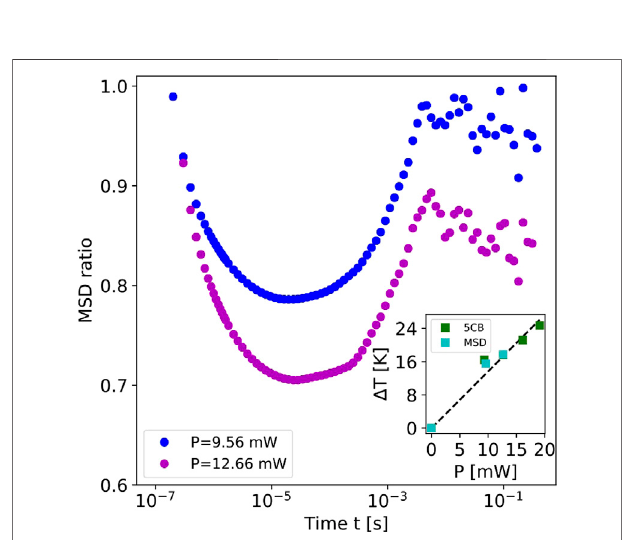
FIGURE 7 | Calculated ratio of the mean squared displacement for the 2.15 µm diameter AuPS particle at different heating powers with a 532 nm laser(seelegend). Theinsetdisplays thesurfacetemperature increment ofthe colloids as determined from a separate measurement in a liquid crystal (5CB, see text) as well as from the effective temperature of Hot Brownian Motion ( T HBM ) at large time lags.